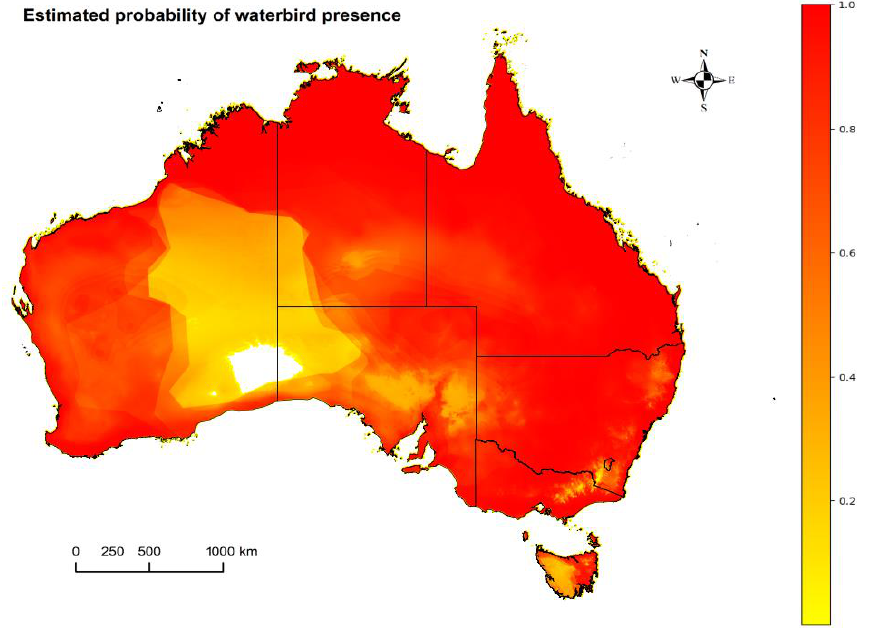
Figure 2. The combined estimated distribution of 12 species of waterbirds suspected to be JEV reservoirs within Australia (from Ardeidae and Ciconiidae families), where the probability of presence ranges from zero (white) and low (yellow) to high (red).